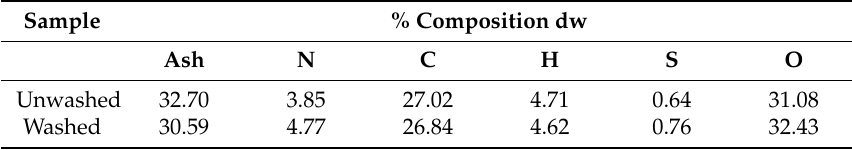
Table 2. Elemental composition of S. muticum before and after freshwater